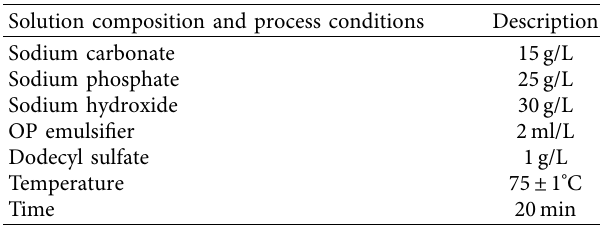
Figure 2: Chemical composite coating flow chart. Table 1: Chemical degreasing parameters.